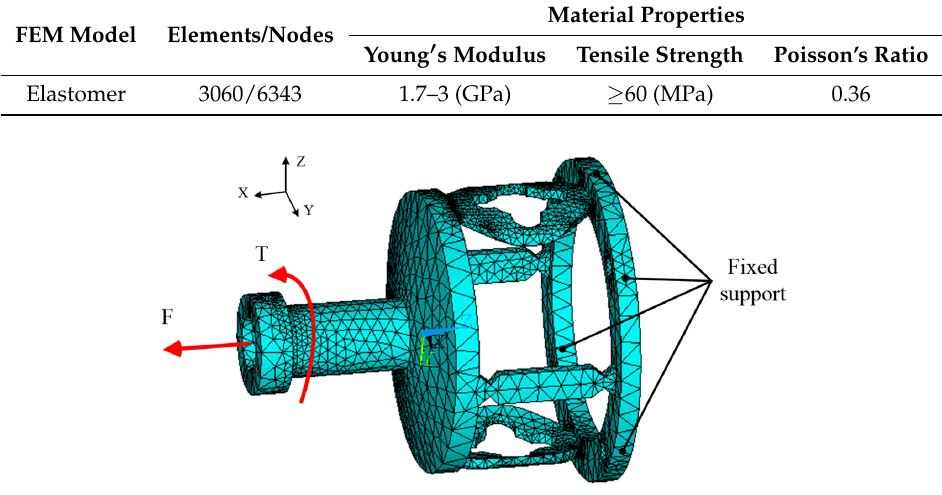
Figure 4. The finite element model of the elastomer.